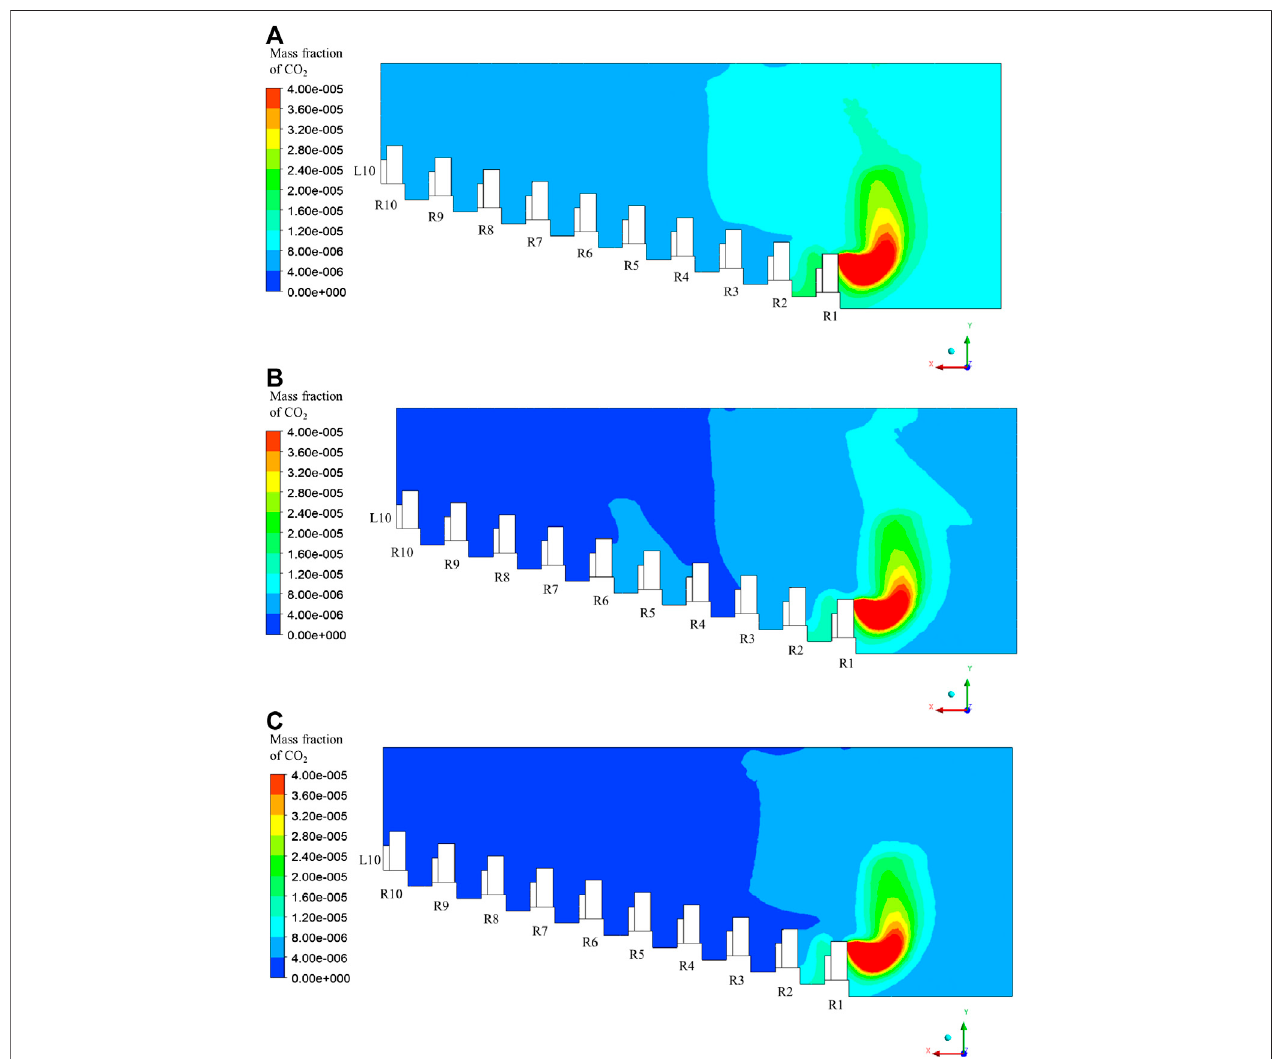
FIGURE 7 | Distribution of mass fraction of CO 2 in Plane 2: (A) Case 1; (B) Case 2; (C) Case 3.